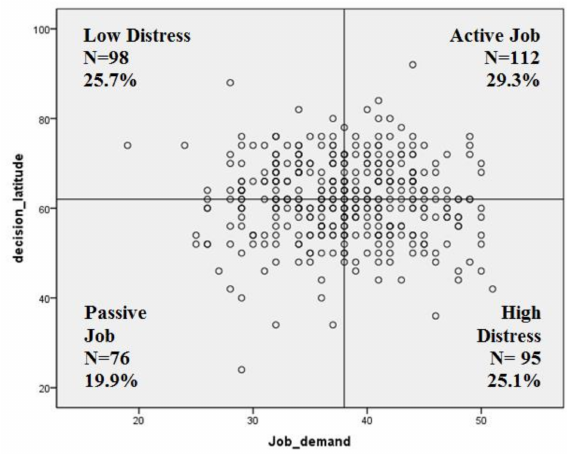
Figure 1. Scatter-plot of Job Demand-Control Model (sample N =